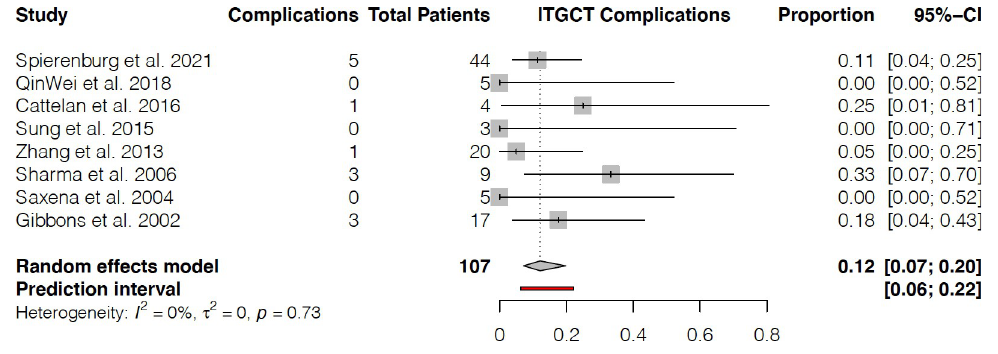
Fig 3. Complications in patients with